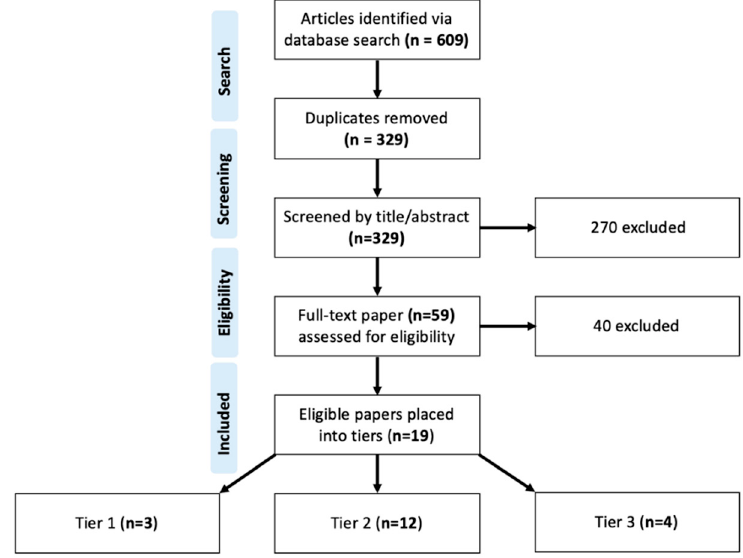
Figure 1. Systematic Review Flow Diagram.